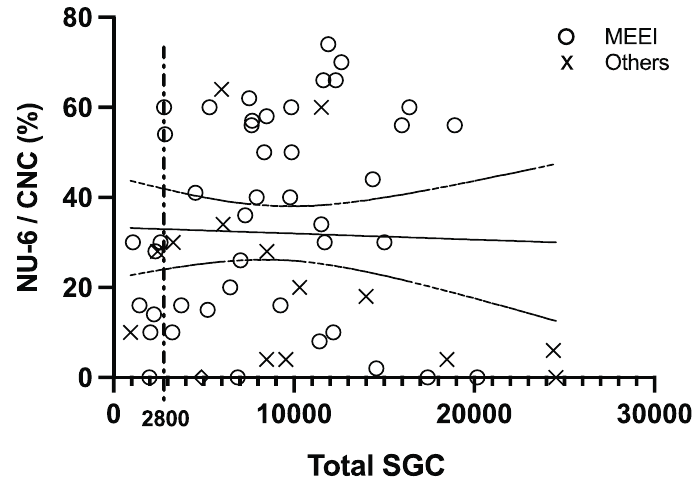
Figure 2. Speech perception scores as a function of total number of spiral ganglion cells in patients examined at MEEI (circles) or other sites (X). The vertical line at SGC count = 2800 helps visualize that subjects below that level tend to have lower speech perception